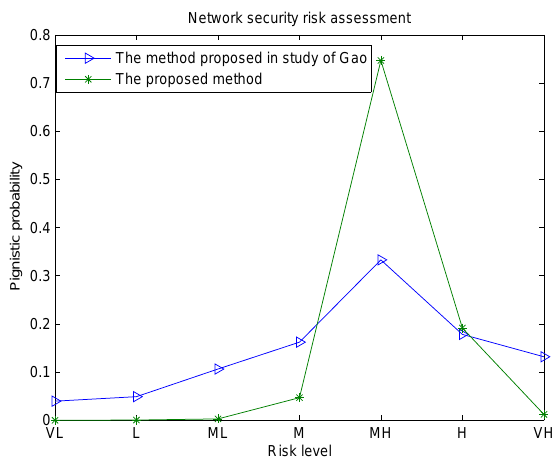
Figure 3. Comparison of evaluation results of different